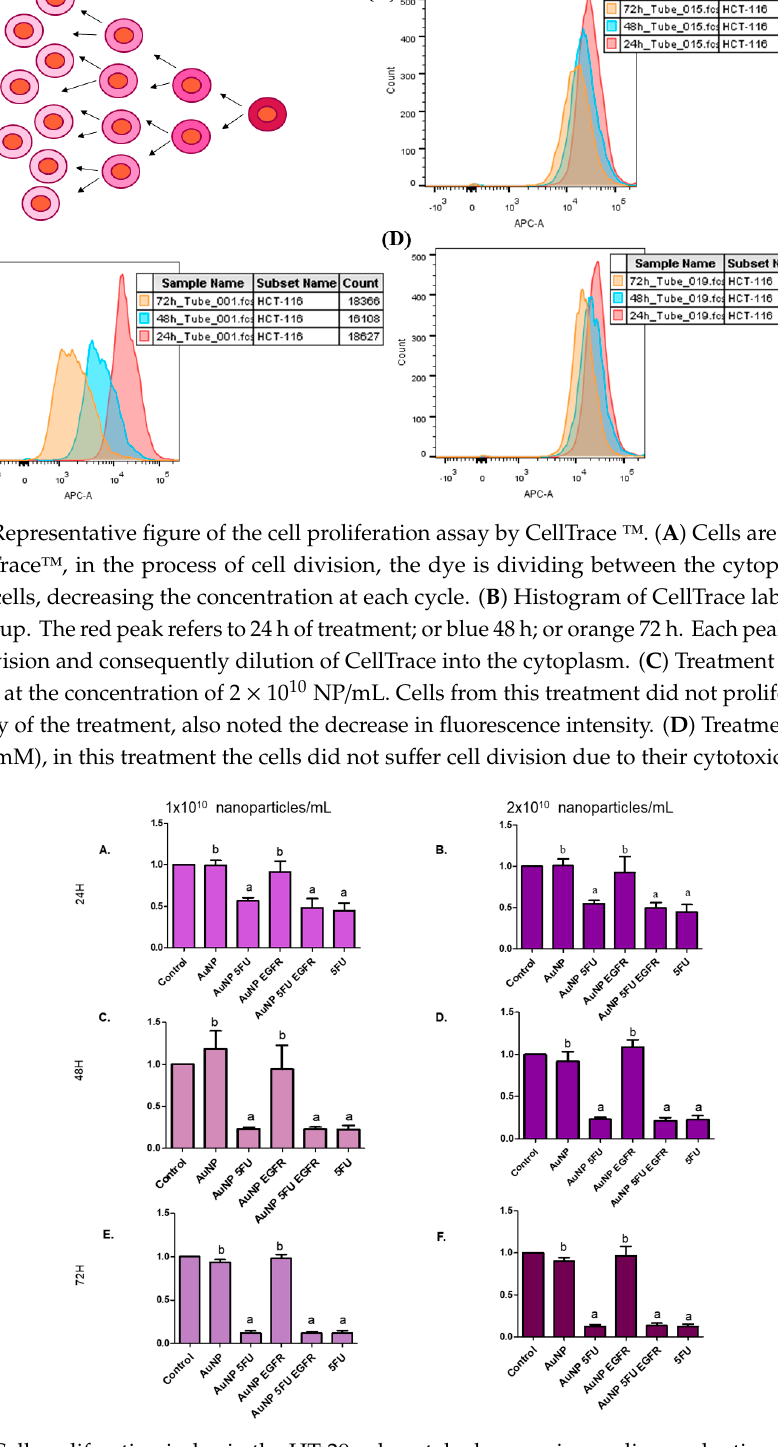
Figure 6. Cell proliferation index in the HT-29 colorectal adenocarcinoma line evaluating the dilution of CellTrace™ into the cytoplasm of cells. The cells were stained, treated (1 or 2 × 10 10 NP/mL) and collected at 24, 48 and 72 h: ( A ) 24 h with 1 × 10 10 NP/mL; ( B ) 24 h with 2 × 10 10 NP/mL; ( C ) 48 h with 1 × 10 10 NP/mL; ( D ) 48 h with 2 × 10 10 NP/mL; ( E ) 72 h with 1 × 10 10 NP/mL and ( F ) 72 h with 2 × 10 10 NP/mL. Statistical analysis was performed by one-way ANOVA followed by Dunnett’s post-test, with significance of p < 0.05.